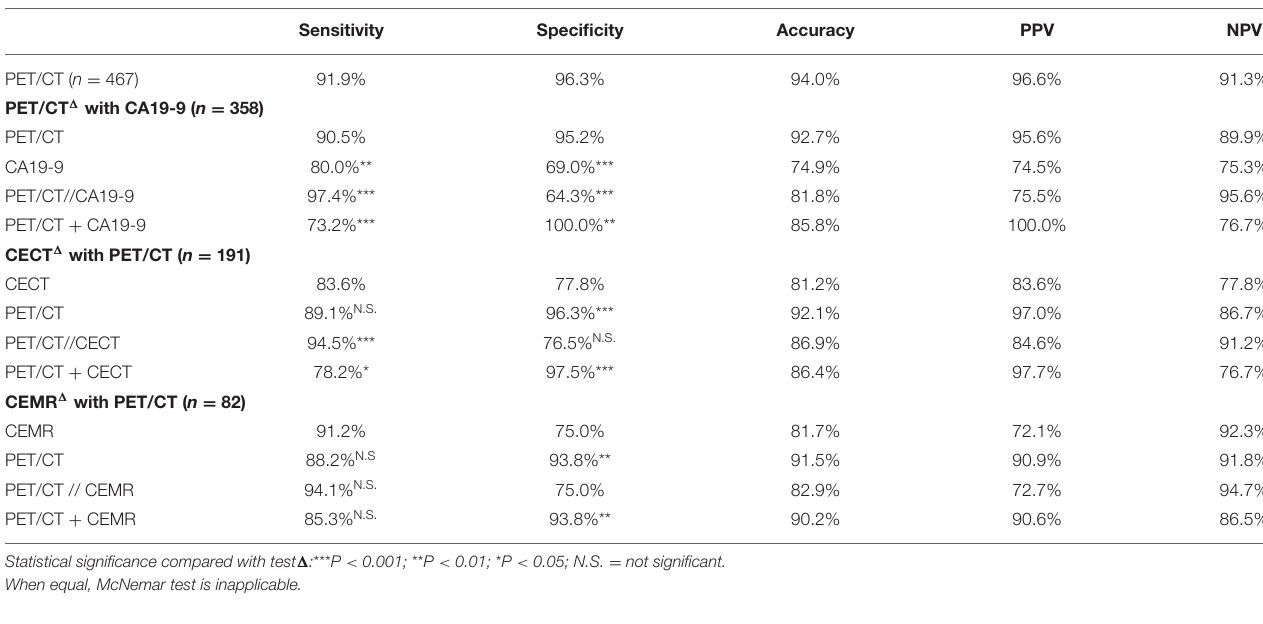
TABLE 4 | Diagnostic efficiency of PET/CT compared with other tests.